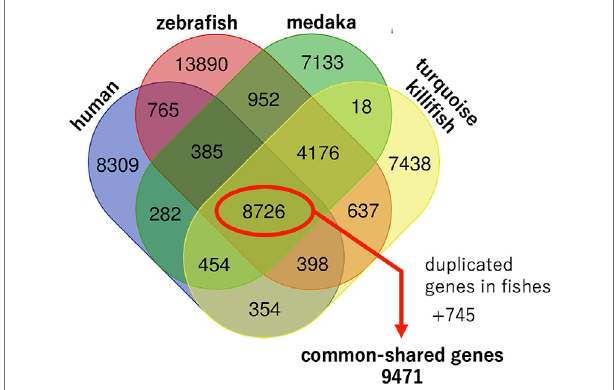
FIGURE1| Genomiccharacteristicsofhumans,zebra fi sh,medaka,and turquoise killi fi sh. Venn diagram generated by an exact match with gene symbols normalized as strings. In addition to 8,726 common shared genes, duplicated orthologues in fi shes were extracted and an additional 745 common shared genes were found. In total, 9,471 common shared genes were found among the four